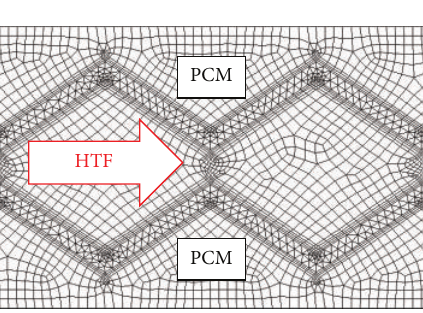
Figure 5: Schematic representation of the zigzag plate on 2D base grid.